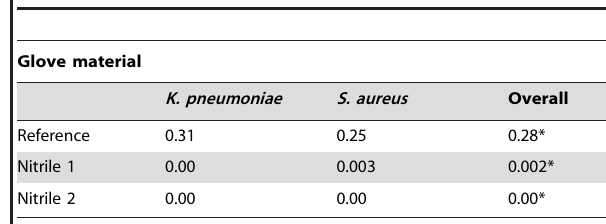
Table 1. Mean zones of inhibition (cm) among three types of glove